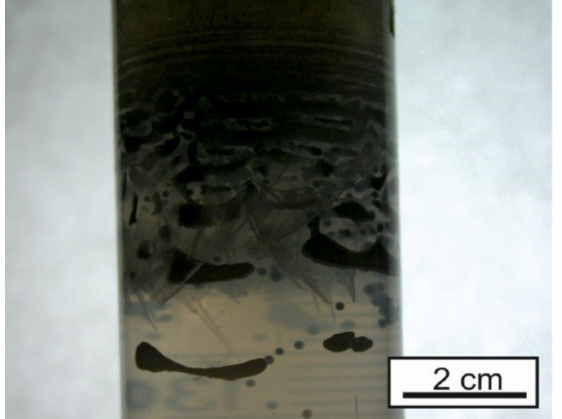
Figure 9. Due to its higher crystallization pressure, brushite, CaHPO 4 · 2H 2 O, grows as centimeter- sized laths, cross-cutting Liesegang rings of hydroxylapatite, Ca 5 (PO 4 ) 3